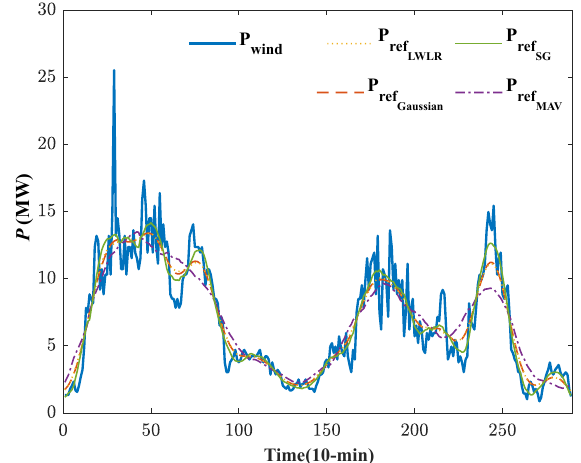
Figure 7. Actual and smoothed wind power